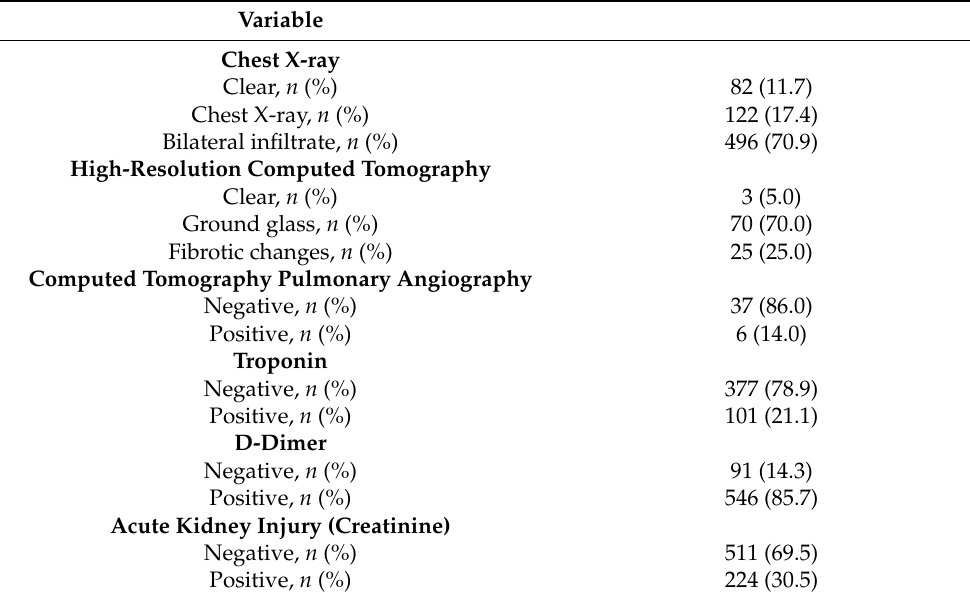
Table 2. Clinical Findings, Laboratory Investigations, and Treatments ( n = 745).